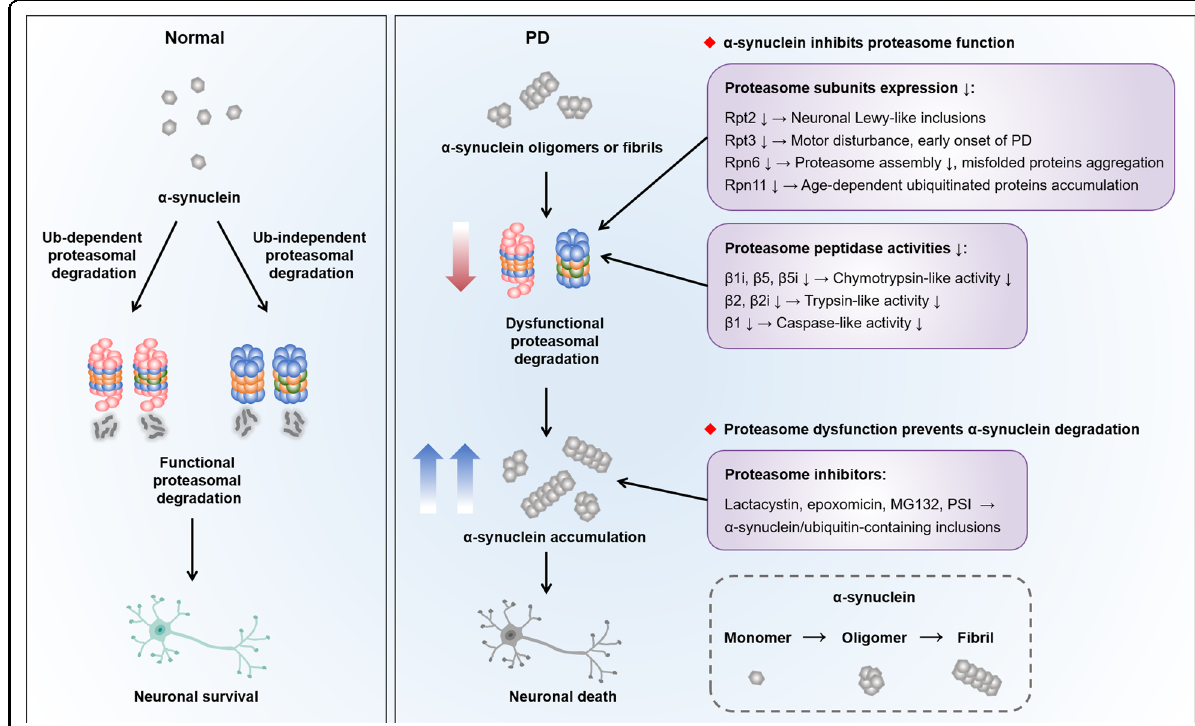
Fig. 3 The interplay between proteasome impairment and α -synuclein accumulation in PD. Under physiological state, α -synuclein is highly soluble and enriched at presynaptic terminals, which can be degraded through ubiquitin-dependent and ubiquitin-independent manner, so as to maintain the survival of neurons. In PD, α -synuclein accumulates in neuronal cell bodies to form a major component of aberrant aggregates known as Lewy bodies. α -synuclein is able to transform in different conformations, including monomers, oligomers (soluble conformations), and fi brils (insoluble conformations). The impairment of proteasome function resulting from the decreased subunits expression and proteolytic activities disturbs the degradation of substrates. Additionally, α -synuclein has been reported to inhibit the function of proteasome, which further aggravates the accumulation of α -synuclein. This suggests a vicious cycle between proteasomal impairment and proteotoxicity in